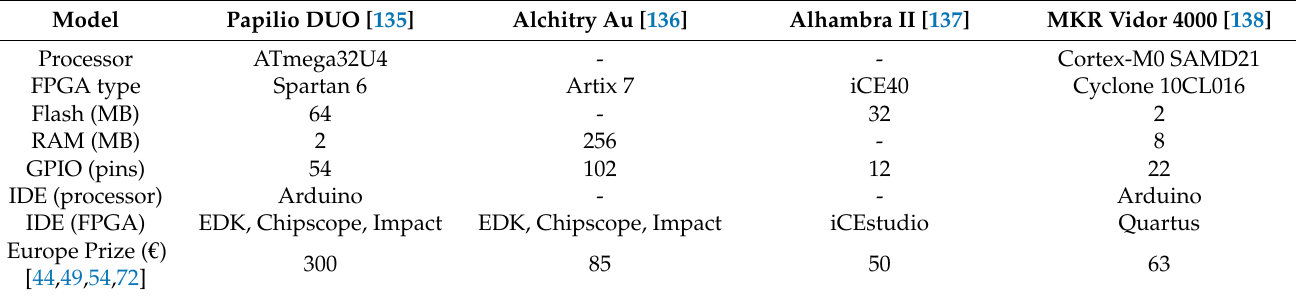
Table 6. Table 6. Open-source SBAs with FPGA.